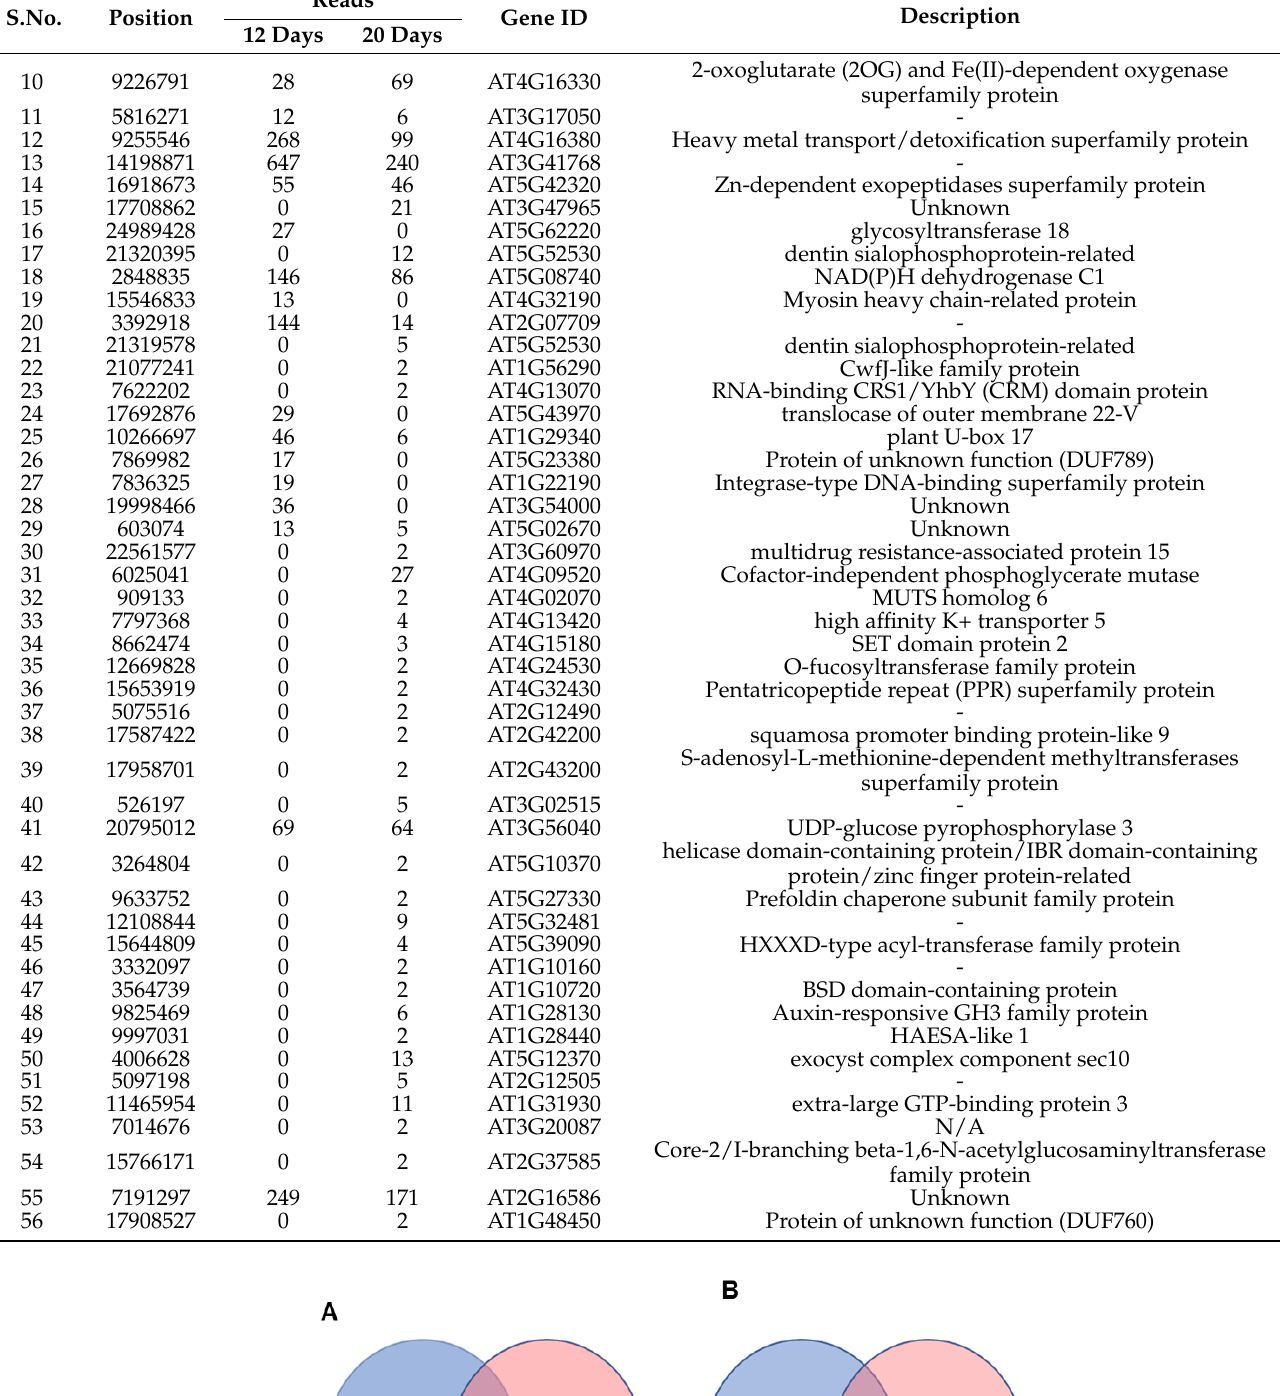
Figure 3. The next-generation sequencing (NGS) data of Arabidopsis for expressed PPR genes. Out of 465 expressed PPR genes, 10 genes including AT3G62470, AT1G50270, AT1G16830, AT1G63080, AT1G06580, AT3G56550, AT1G09820, AT3G53360, AT2G22410, and AT4G32430 showed nucleotide conversion ( A ). Out of 54 U-to-C variant genes, one gene, AT4G32430, was